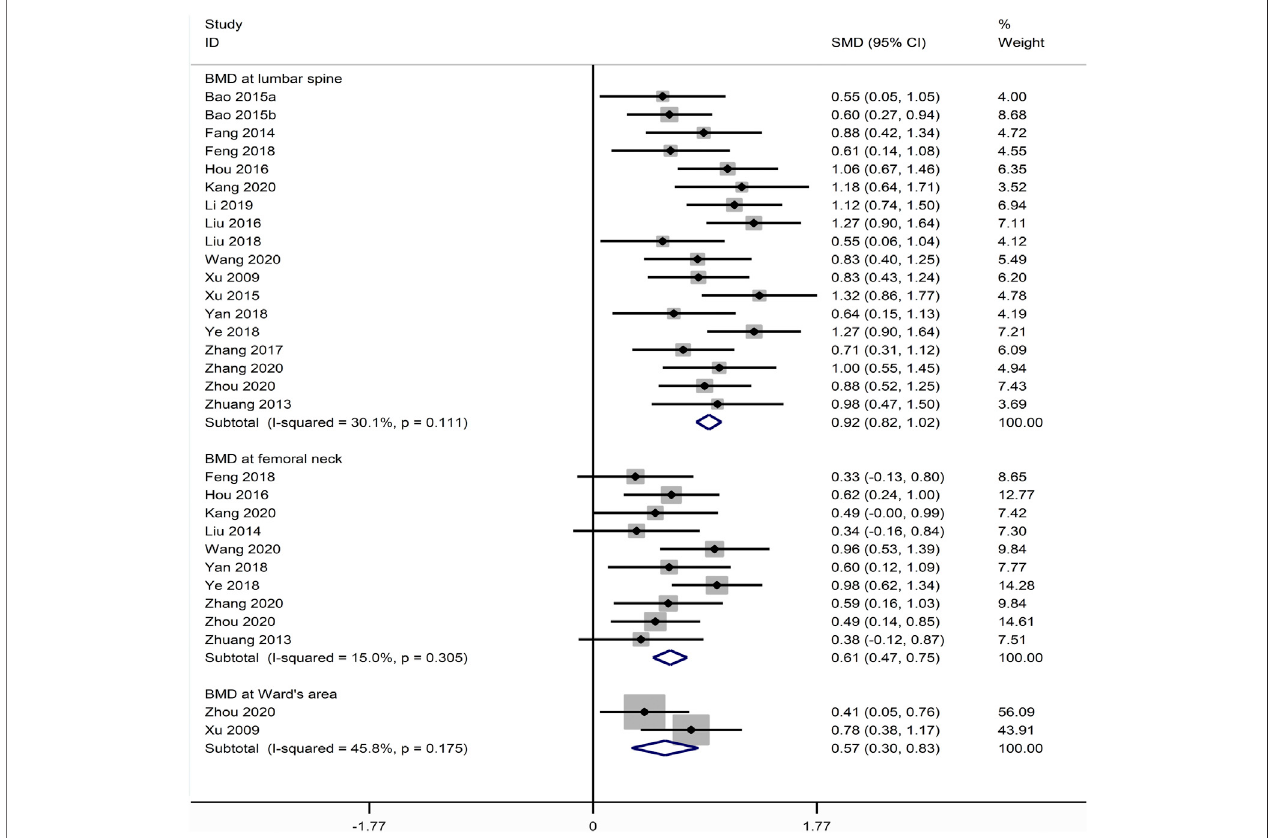
FIGURE 6 | Forest plot of XLGB combined with ALE vs. ALE alone with regard to BMD at lumbar spine (A) BMD at femoral neck (B) and BMD at Ward ’ s area (C) .